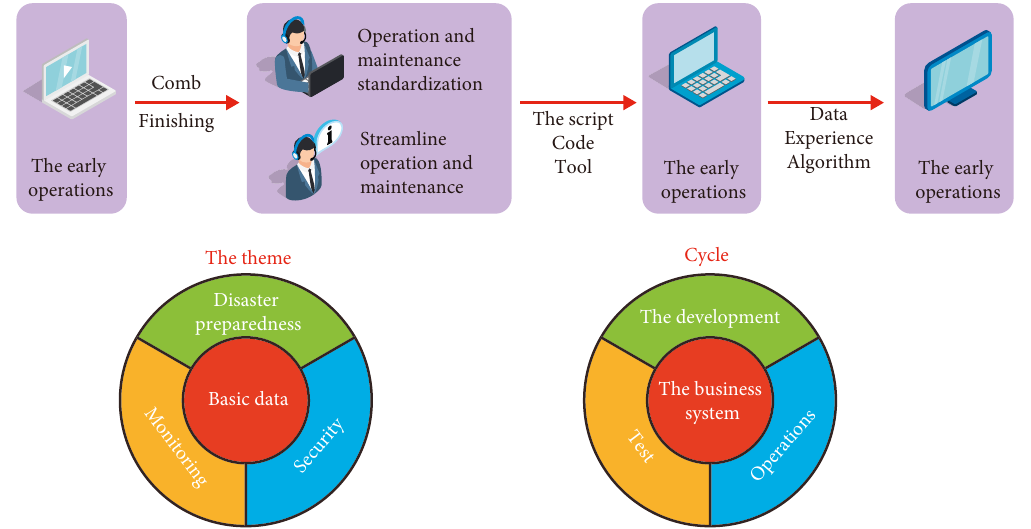
Figure 1: Management system of small- and medium-sized